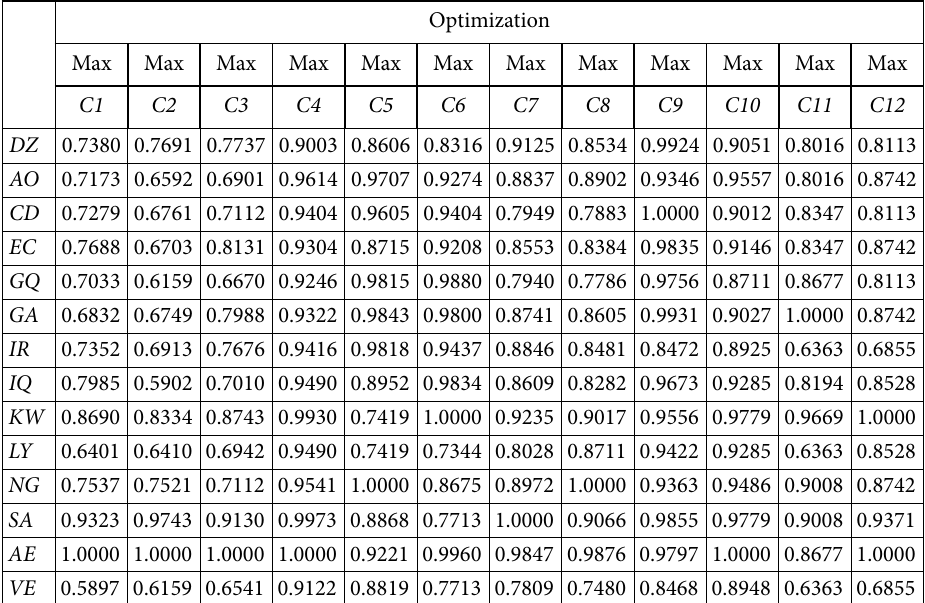
Table 5. Vector normalization